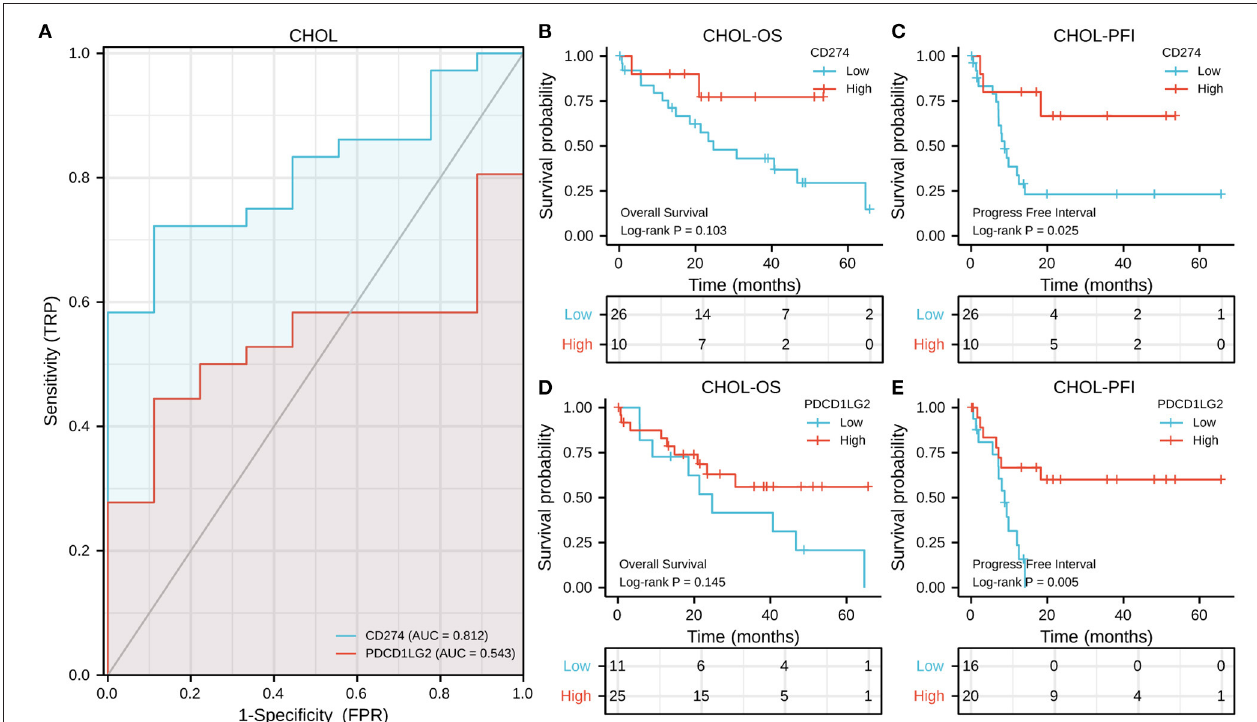
FIGURE 2 | CD274/PDCD1LG2 expression and its correlation with cholangiocarcinoma (CHOL) patient survival. (A) Receiver operating characteristic (ROC) curves CD274/PDCD1LG2 of distinguishing tumor from normal samples. (B,C) The Kaplan–Meier (KM) analysis shows the association between the CD274/PDCD1LG2 expression and overall survival (OS). (D,E) CD274/PDCD1LG2 expression and progression-free interval